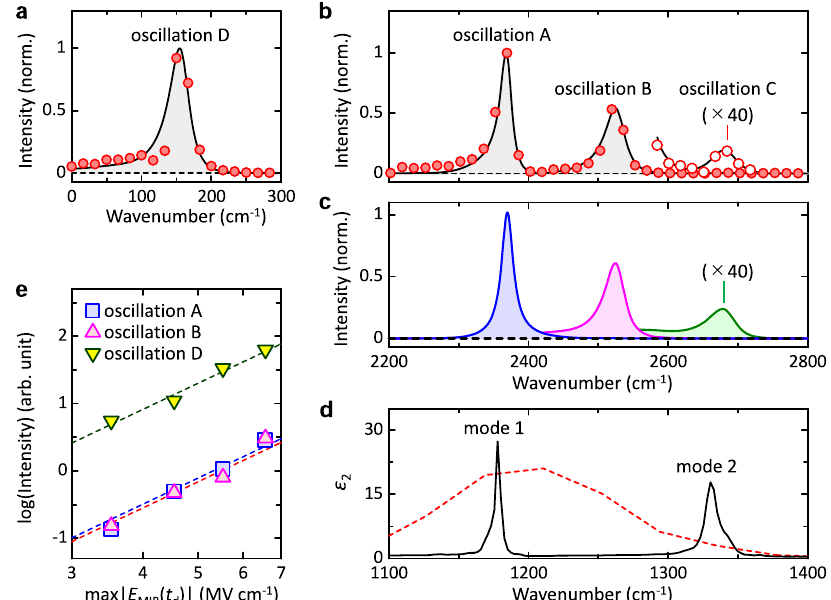
Fig. 3 High- and low-frequency oscillatory components in optical responses associated with phonon-dressed states in K-TCNQ. a The Fourier power spectrum of the low-frequency oscillation D in Δ I R ð t d Þ = I R (red circles) and the calculated oscillation obtained from the fi tting analysis of the time characteristic of Δ I LF ð t d Þ = I R (the black line). b The Fourier power spectrum of the high-frequency oscillatory component Δ I HF ð t d Þ = I R (red circles) and the fi tting curve (the black line). c Spectra of three oscillations A – C obtained by the fi tting analysis of the time characteristic of the high-frequency oscillatory component Δ I HF ð t d Þ = I R in Δ I R ð t d Þ = I R shown in Fig. 2j. d The ε 2 spectrum along the a -axis. The spectrum of the mid-infrared pump pulse (pump II) is shown by the red broken line. e Intensities of three oscillatory components A, B, and D, obtained from the fi tting analyses of Δ I HF ð t d Þ = I R and Δ I LF ð t d Þ = I R . The error bars, de fi ned as one standard deviation of the least-squared fi t, are smaller than the data